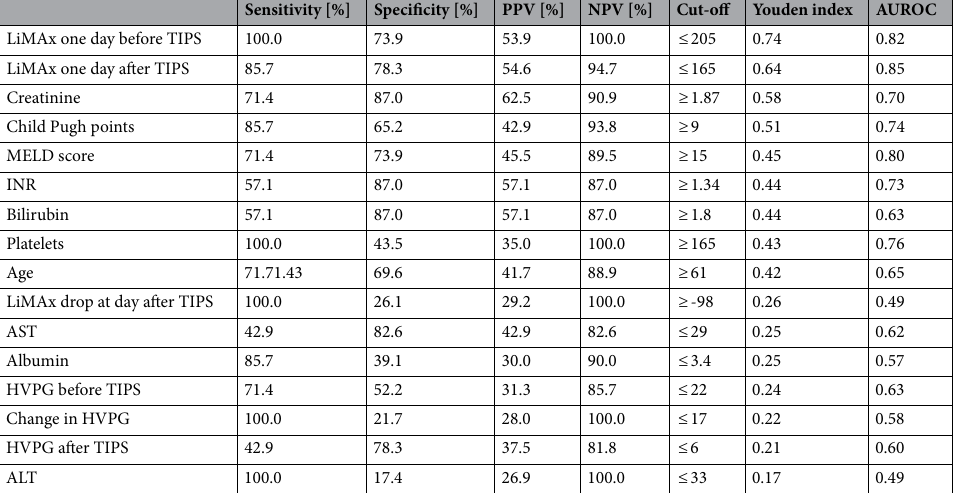
Table 3. Analysis of diagnostic accuracy of different parameters in prediction of transplant-free survival after TIPS. ALT alanine aminotransferase, AST aspartate aminotransferase, AUROC area under receiver operating characteristics, HVPG hepatic venous pressure gradient, INR international normalized ratio, MELD model for end-stage liver disease, NPV negative predictive value, PPV positive predictive value, TIPS transjugular intrahepatic portosystemic